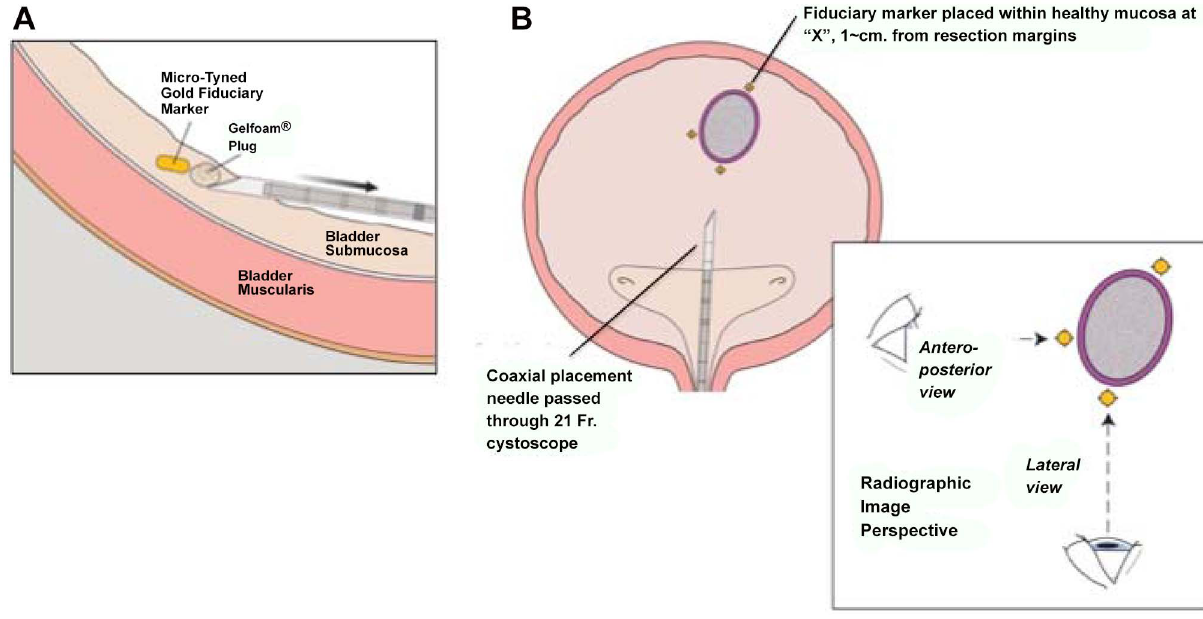
Figure 3. A. During placement, the tip of the deployment needle should be tunneled (approximately parallel to the bladder wall) a short distance beneath the mucosa before the stylet is advanced to deploy the marker and Gelfoam TM plug. Submucosal tissue collapses upon the micro-tines, to anchor the fiducial marker in place and prevent marker migration. B. A minimum of three markers are placed around a single tumor site. Markers should be oriented circumferentially in a trident (e.g. Mercedes H -sign) rotated 30–60-degrees, such that when the three + markers are viewed by radiograph from either an anterior-posterior view and a lateral view, each is distinct and does not overlap with the others.